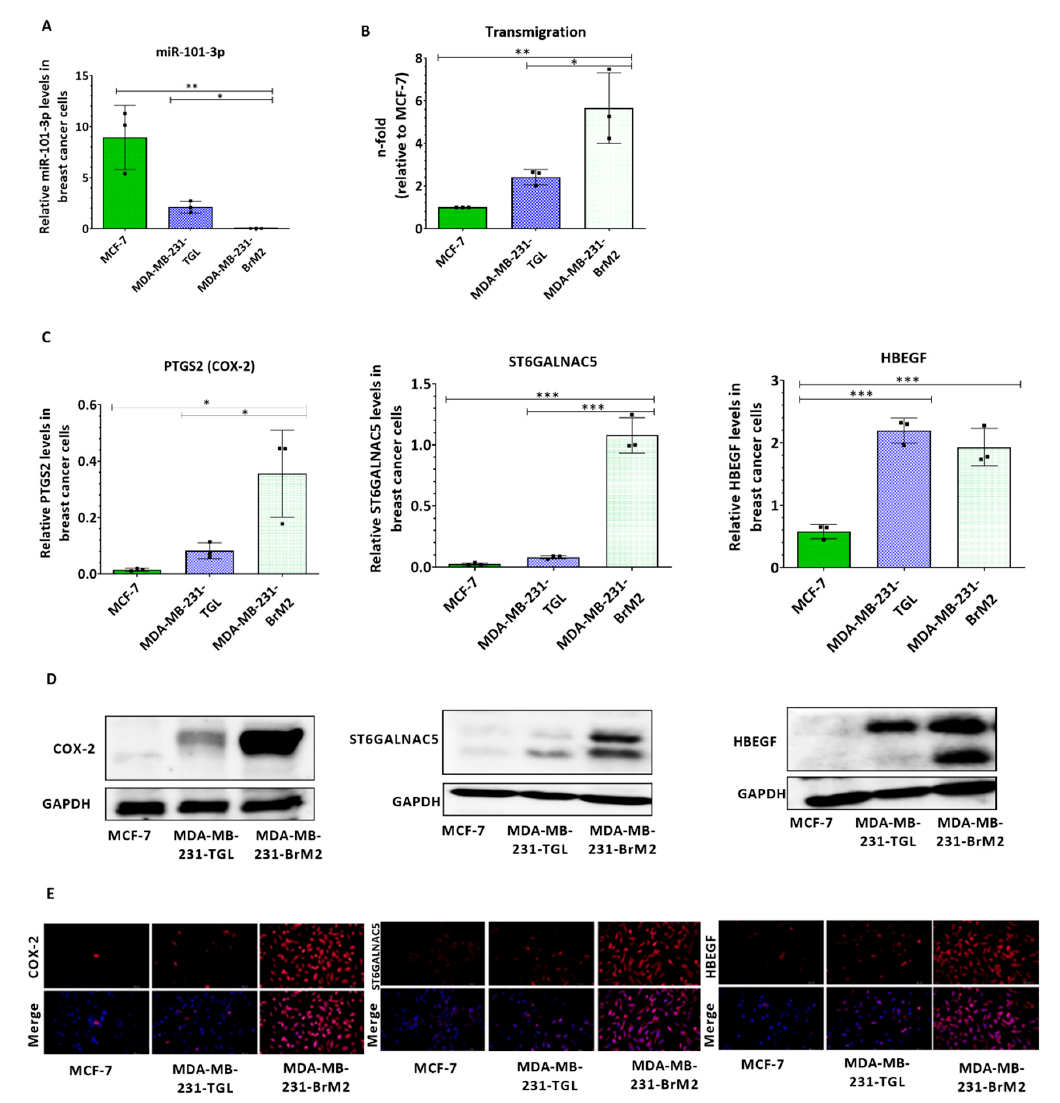
Figure 1. miR-101-3p levels are downregulated in brain metastatic breast cancer cells and vary inversely with their brain metastatic ability. ( A ) The expression profile of miR-101-3p was examined by real-time PCR in three breast cancer cell lines with different brain metastatic propensities (MCF-7, MDA-MB-231-TGL and MDA-MB-BrM2). Relative miR-101-3p level expression was normalized against the U6 small nuclear RNA levels. ( B ) The transmigration abilities of the different BC cells were examined by trans-endothelial migration assay. The amount of transmigrated cells was determined by fluorescence measurements.( C ) The relative mRNA expression profile of three pro-metastasis genes known to mediate brain trans-endothelial migration of BC cells (PTGS2 coding for COX-2, ST6GALNAC5 and HBEGF) was examined in the three BC cell lines using real time PCR and normalized against GAPDH mRNA levels.( D , E ) Western Blot analysis ( D ) and immunofluorescence images ( E ) of COX-2, ST6GALNAC5 and HBEGF in MCF-7, MDA-MB-231-TGL and MDA-MB-BrM2 cell lines. Experiments were carried out three times. Data are mean ±SD from three independent experiments. * p < 0.05, ** p < 0.01, *** p < 0.001.